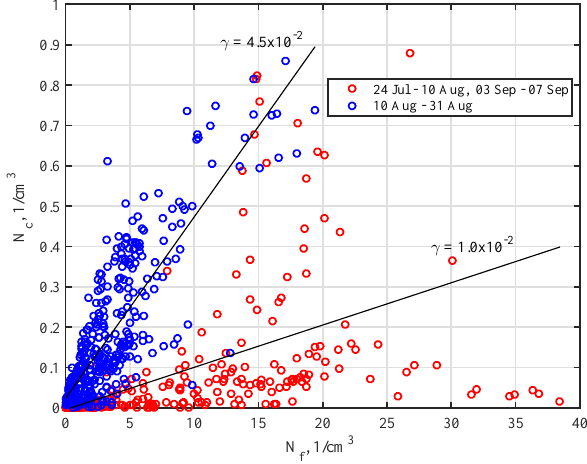
Figure 11. The scatter diagrams of number concentrations of sub- micron N f and coarsely dispersed N c aerosol at middle (red) and high (blue)